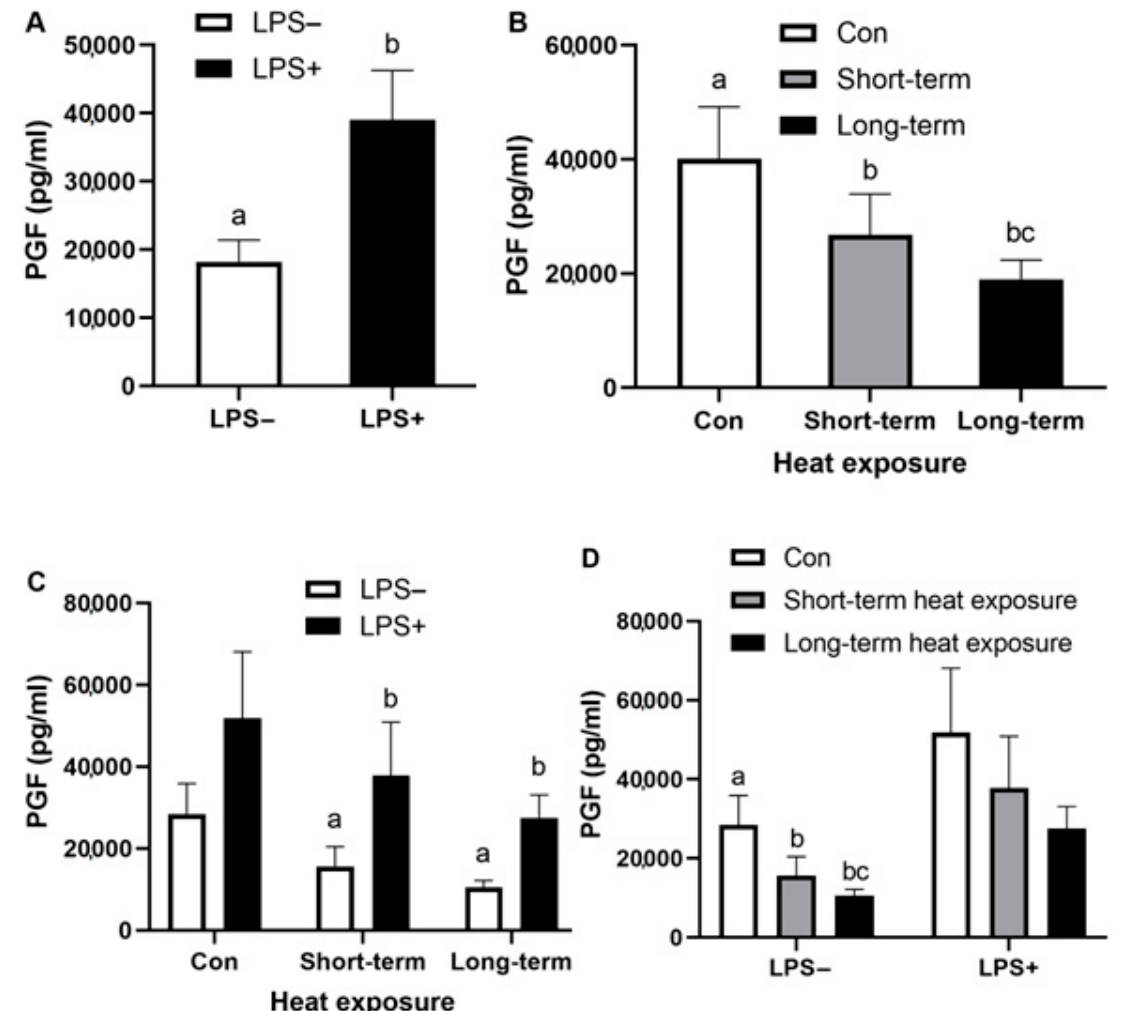
Figure 4. Secretion of PGF2 α (pg/mL) in the medium of bovine endometrial cells cultured in the presence or absence of 100 ng/mL LPS with different heat exposure (control: Con; short-term heat exposure; long-term heat exposure). Treatments were replicated three times, and the experiment was conducted on four separate occasions. Different superscripts indicate significant differences (p < 0.05), as determined by a mixed model analysis using two fixed factors—LPS treatment ( A ) and heat exposure ( B )—followed by Bonferroni post hoc test ( C , D ). Values are mean ± SEM.